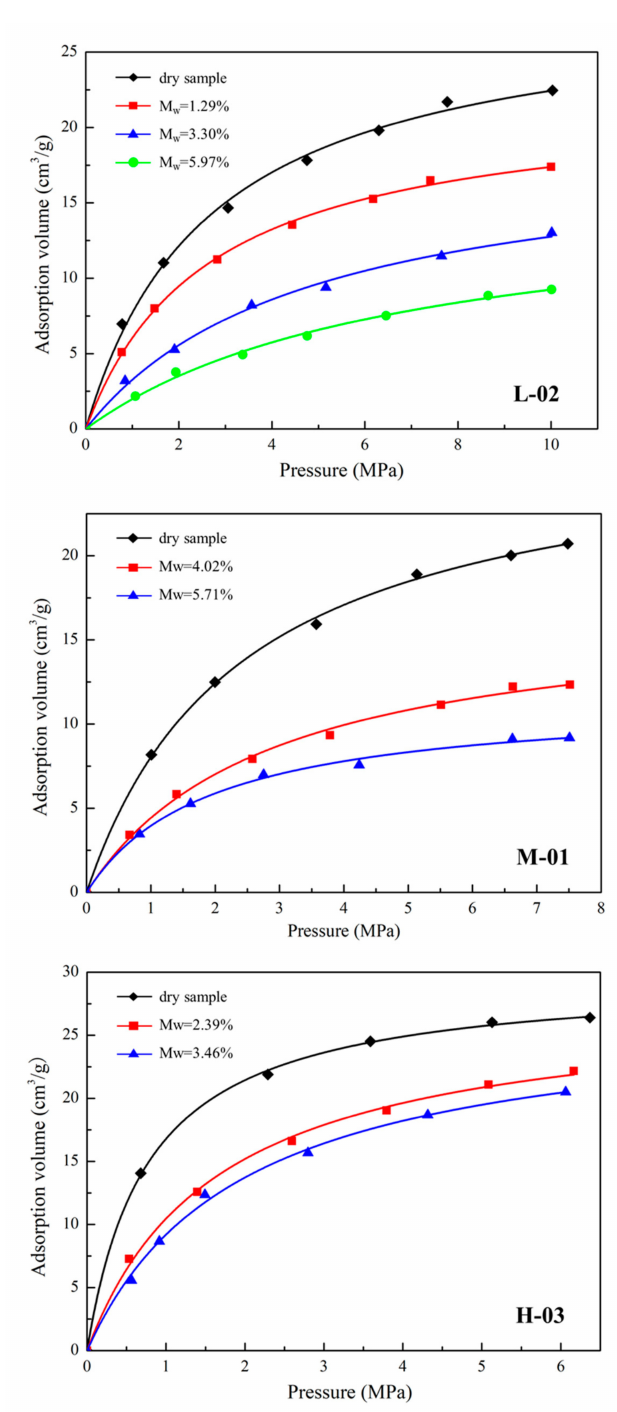
Figure 4. Isothermal adsorption curves of samples with di ff erent moisture